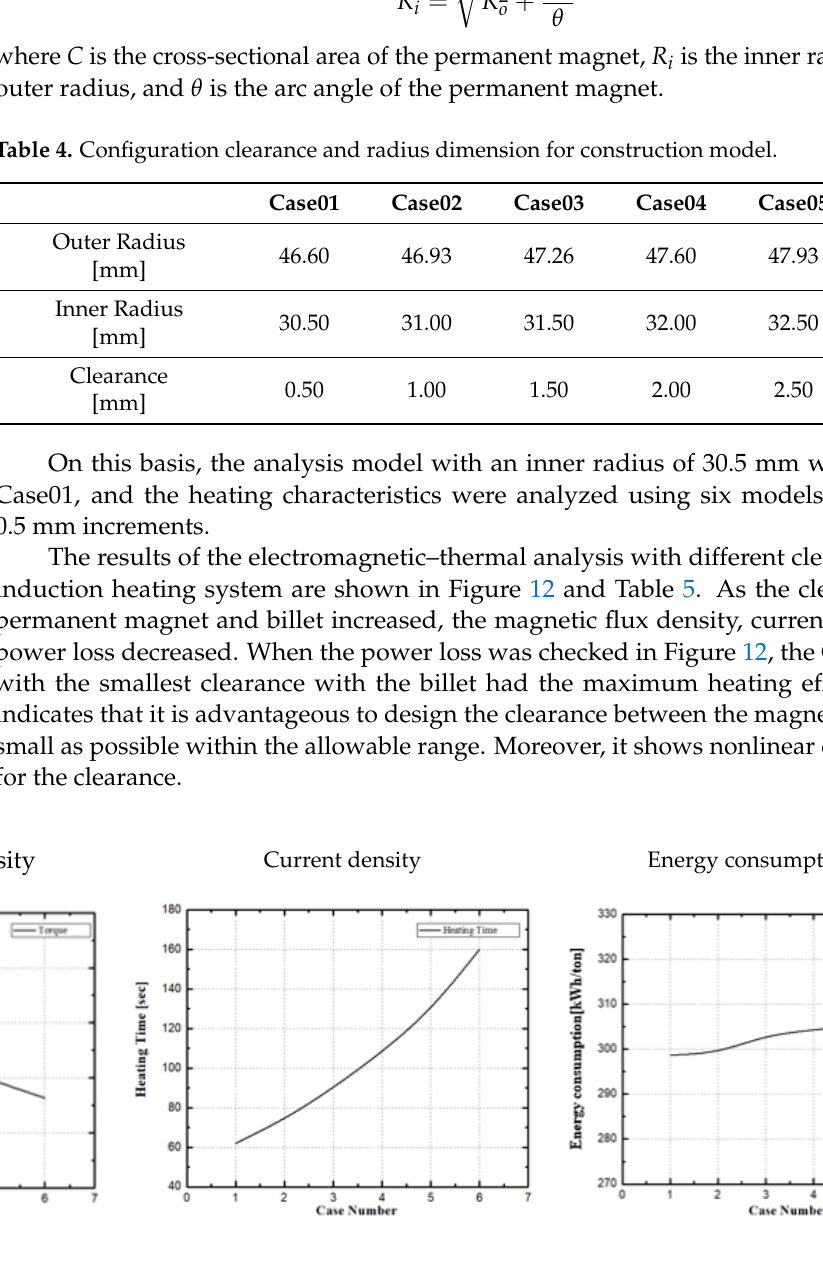
Table 4. Configuration clearance and radius dimension for construction model.